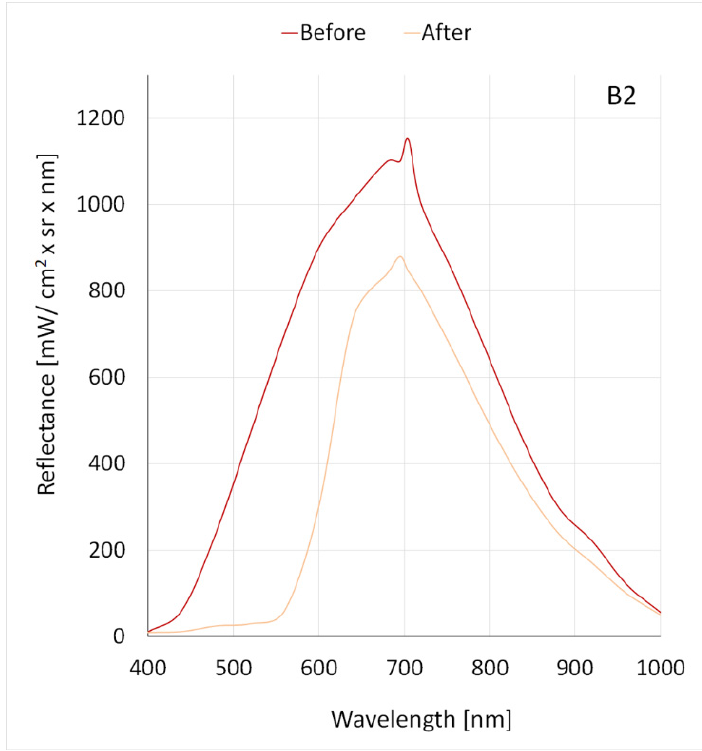
Figure 6. The correlation between the reflectance and the wavelength for the B1 dye before and after the Q ‐ Switched Nd:YAG laser application .